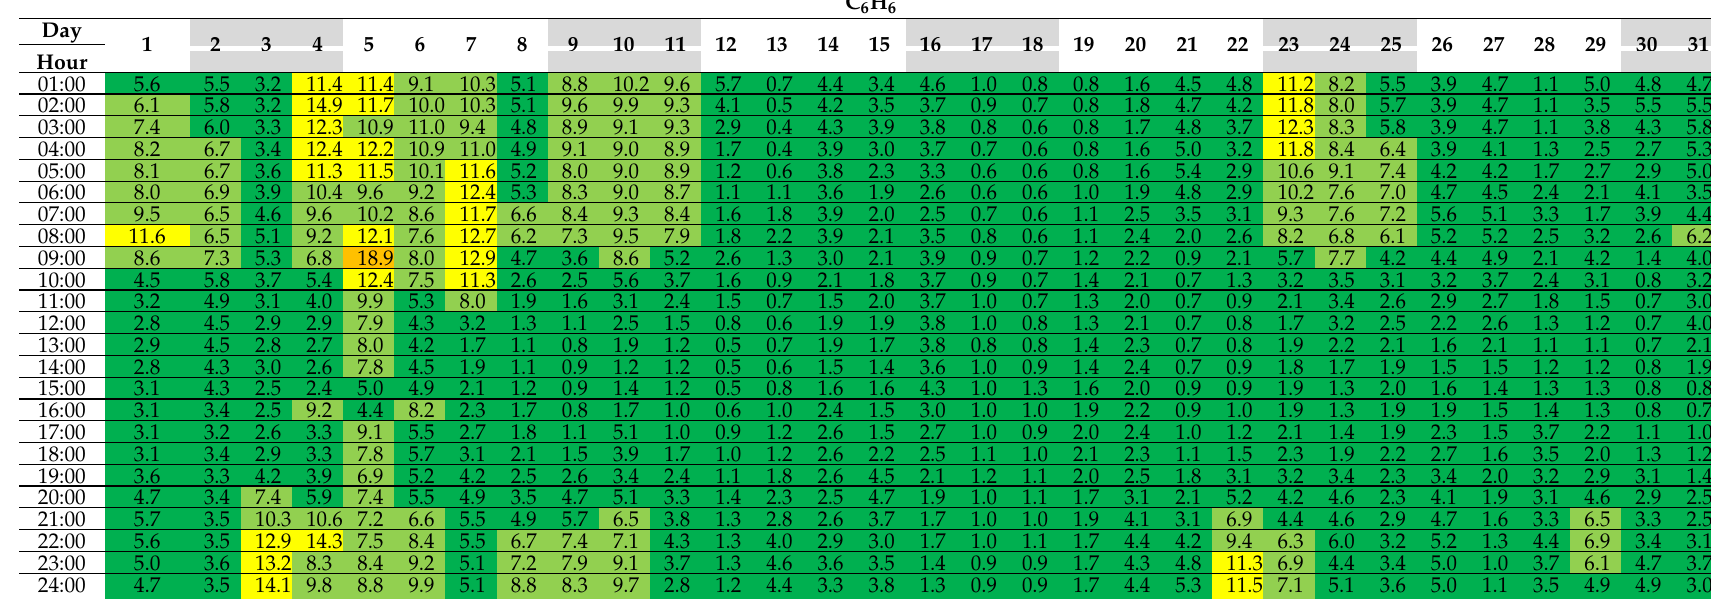
Table 3. Daily and hourly C 6 H 6 content changes, with the hourly Polish AQI, average values for Krak ó w, March 2018 [39] (weekend marking in grey). C 6 H